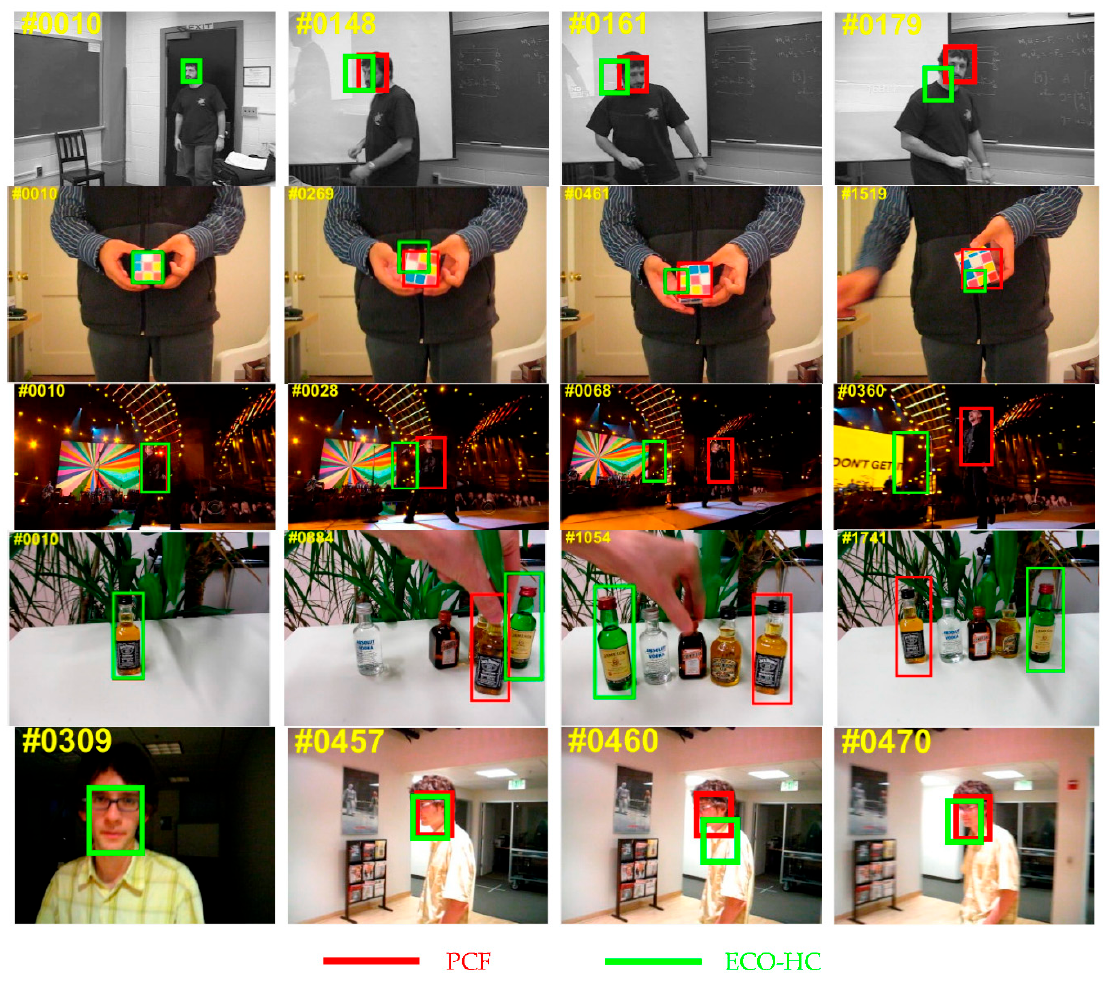
Figure 2. The qualitative comparisons of the proposed parallel correlation filters (PCF) tracker with the baseline tracker efficient convolution operators with hand-crafted features (ECO-HC) on five challenging sequences of the benchmarks. The results are marked in different colors. On all these five cases, PCF tracker performs better center position precision and overlap precision than the baseline tracker. PCF tracker successfully tracks the target when the target undergoes significant rotation, illumination variation, and deformation.